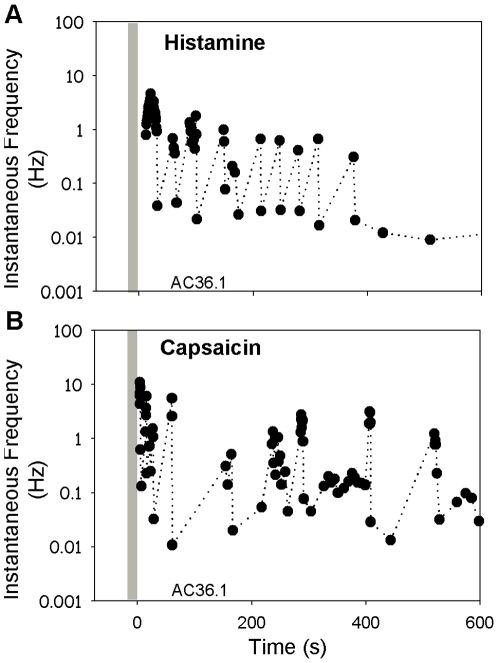
Mechanically-insensitive afferent fiber responds to histamine and capsaicin.The C-fiber mechanically-insensitive afferent identified as AC36 in Fig. 3Cresponded to intradermal injection of histamine (10 g/10 l) and capsaicin (10 g/10 l). The response to both chemicals was greatest during the first 30 s and lasted about 10 min. Instantaneous frequency is plotted as a function of time following injection (each dot corresponds to time of an action potential). Note, there was no response during needle insertion or drug injection (shaded bar).